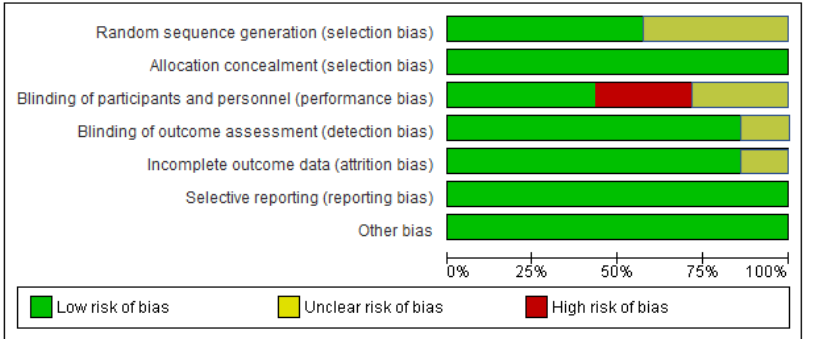
Figure 2. Risk of bias graph: review authors’ judgments about each risk of bias item presented as percentages across all included studies.